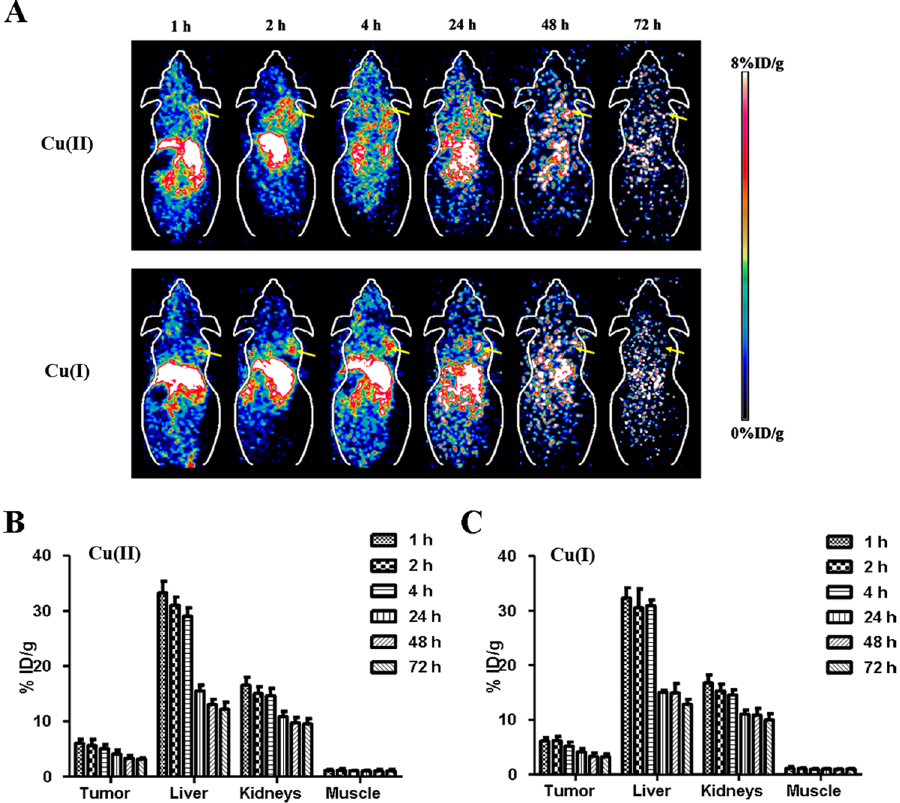
Figure 4. ( A ) Decay-corrected whole-body coronal small-animal PET images of A375M tumor-bearing mice at 1, 2, 4, 24, 48, and 72 h after intravenous injection of 64 Cu(II) and 64 Cu(I), respectively (Tumors are indicated by arrows). ( B and C ) Small-animal PET quantification of tumors and major organs (liver, kidney and muscle) at 1, 2, 4, 24, 48, and 72 h after injection of 64 Cu(II) and 64 Cu(I), respectively (n =